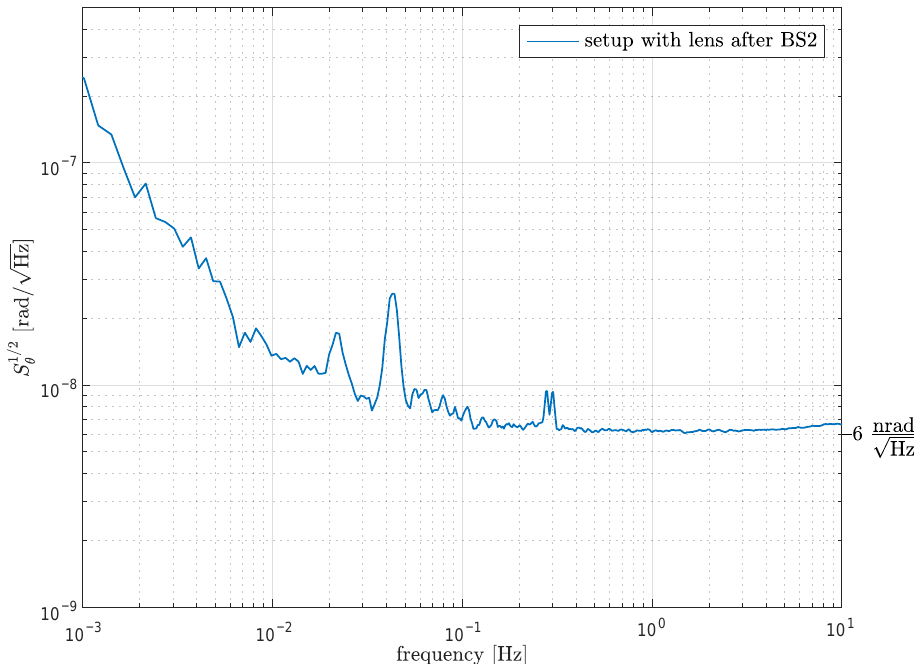
Figure 5. Optimal sensitivity of the test-mass rotation dynamics for the setup with lenses after BS2 calculated by substituting the DWS slope obtained from the simulation with lenses after the beam- splitter in the experiment data reported by Isleif et al [12]. The experiment data was acquired with a very stable quasi-monolithic setup in a vacuum chamber thermalized to a level of 20 µ K Hz − 1/2 at 5